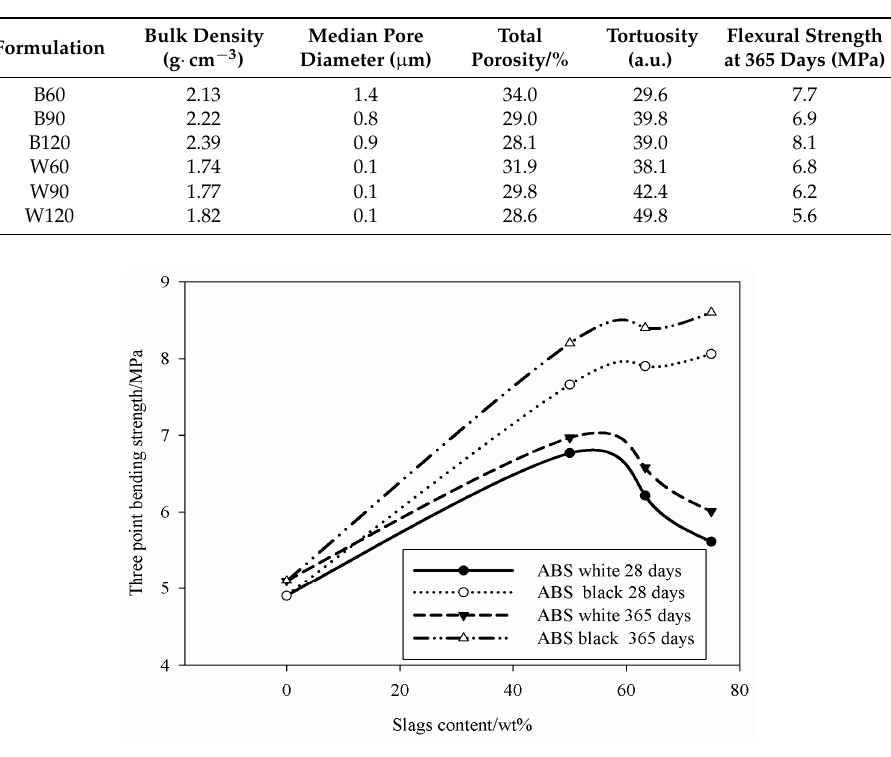
Figure 7. Three point bending strength of slag-based AAS mortars with white and black ABS after 28 and 365 days.